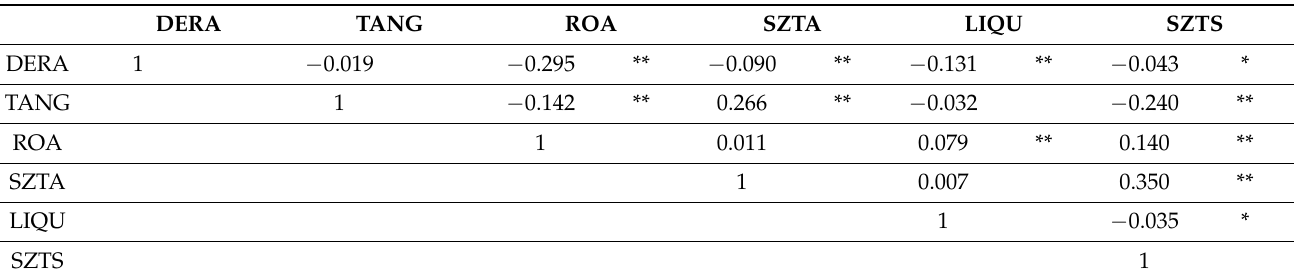
Table 5. Correlation matrix for the total